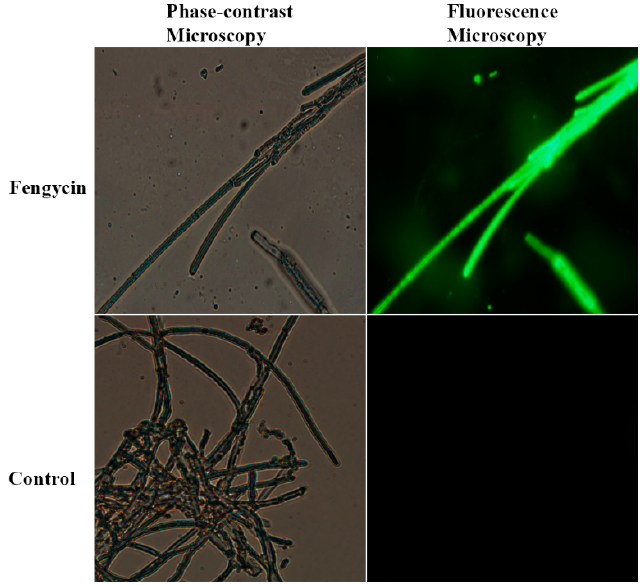
Figure 6. Effect of fengycin (20 µg/mL) on the production of ROS in S. sclerotiorum hyphae. Green fluorescence indicates ROS accumulation in S. sclerotiorum hyphae.